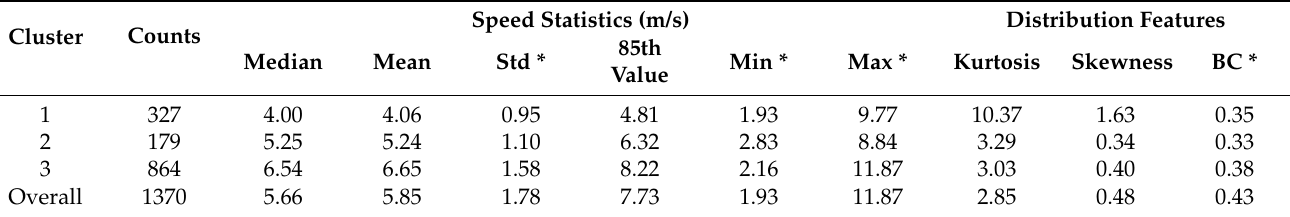
Table 2. Speed statistics and distribution features for the three cluters.